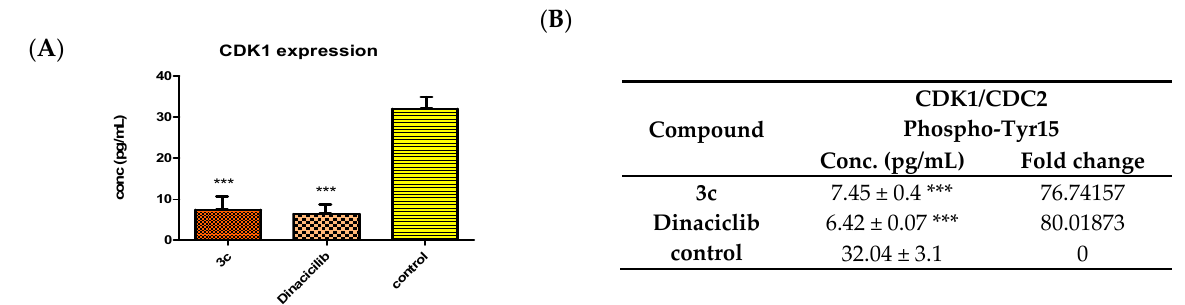
Figure 7. Effect of 3c and Dinaciclib on CDK1/CDC2 phospho-Tyr15 regulation in the SK-MEL-5 cell line. ( A ) Enzyme-Linked Immunosorbent Assay (ELISA) for the immunogen phosphor-peptide for 3a and Dinaciclib and nonphosphopeptide for the control group using the anti-CDC2 (phospho- Tyr15) antibody. ( B ) CDK1/CDC2 phospho-Tyr15 inhibition (conc. (pg/mL) ± SEM) of compound 3c and Dinaciclib. All data were obtained by triplet testing. Results were significantly different from the control at *** p <